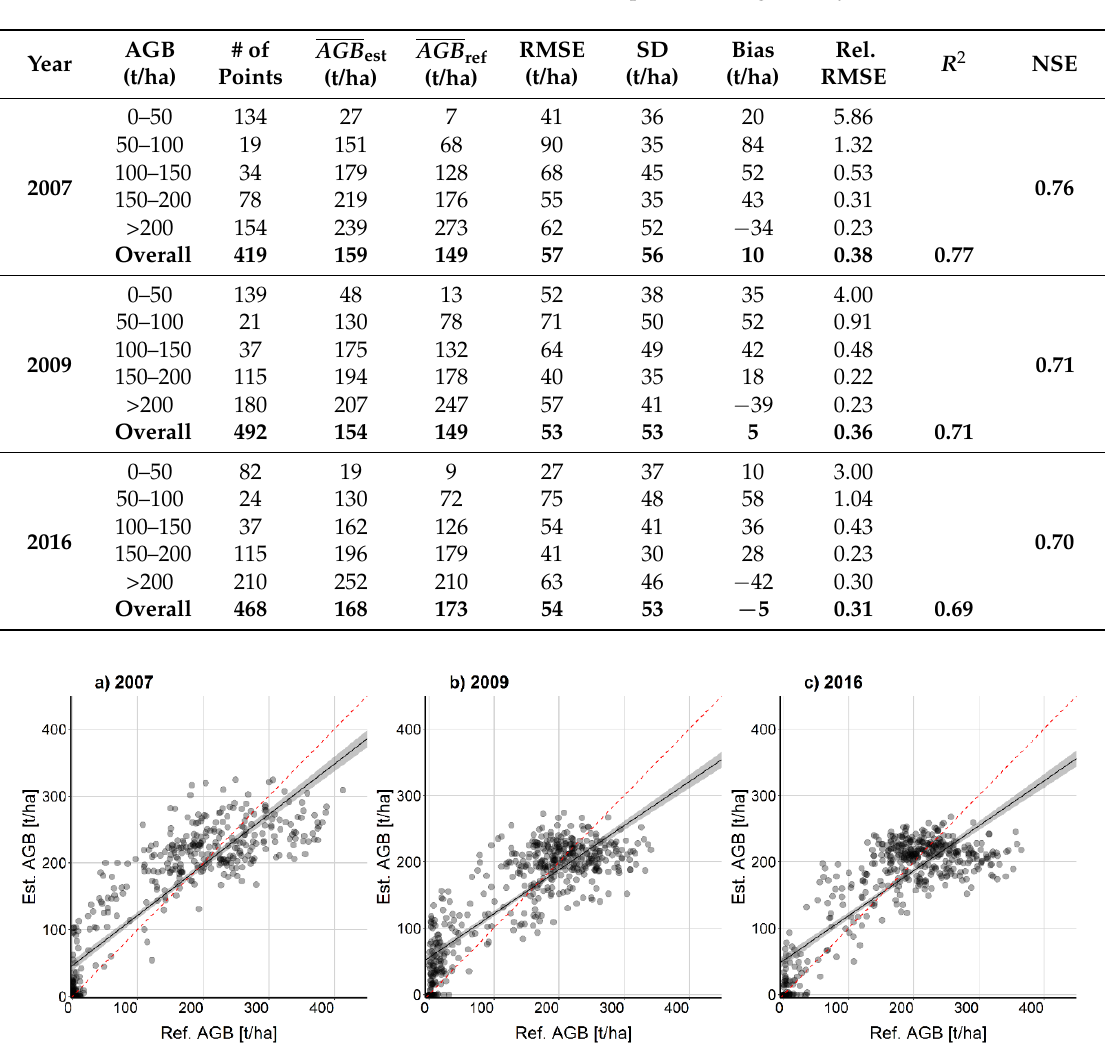
Table 3. Overview of validation statistics per AGB ranges and year.